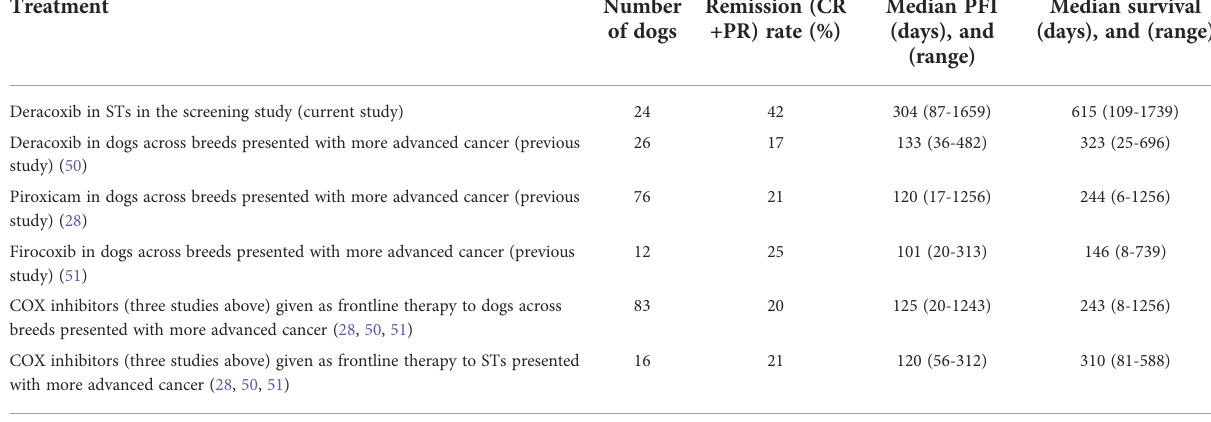
TABLE 5 Results of cyclooxygenase (COX) inhibitor treatment in STs in the screening study and in dogs with later more advanced bladder, i.e. “ symptomatic ” cancer in other published studies (28, 50, 51) a .